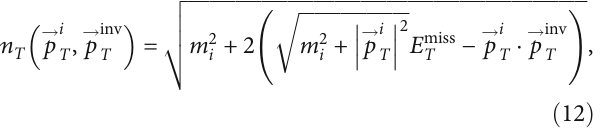
, de fi ned as Table 3: List of cuts performed in the collider analysis. The fi rst T